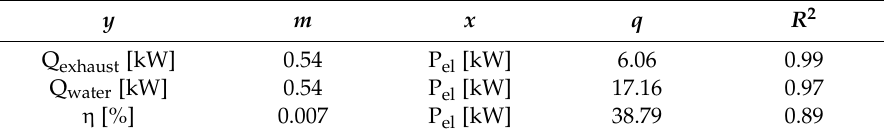
Table 1. Coe ffi cients from linear fitting of the engine curves at nominal